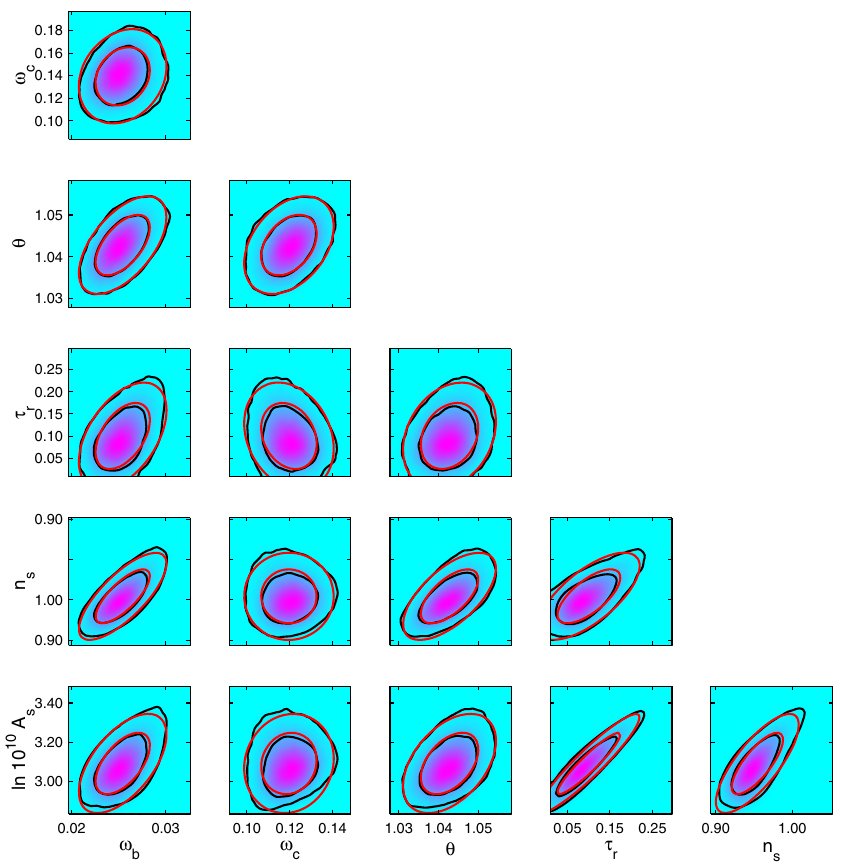
Fig. 63 Gaussian approximation (Laplace approximation) to a 6-dimensional posterior distribution for cosmologicalparameters,fromWMAP1andSDSSdata.Forallcouplesofparameters,panelsshowcontours enclosing68and95%ofjointprobabilityfrom2 × 10 5 MCsamples(blackcontours),alongwiththeLaplace approximation (red ellipses). It is clear that the Laplace approximation captures the bulk of the posterior volume in parameter space in this case where there is little non-Gaussianity in the posterior PDF. Image reproduced from 2005 preprint of Trotta